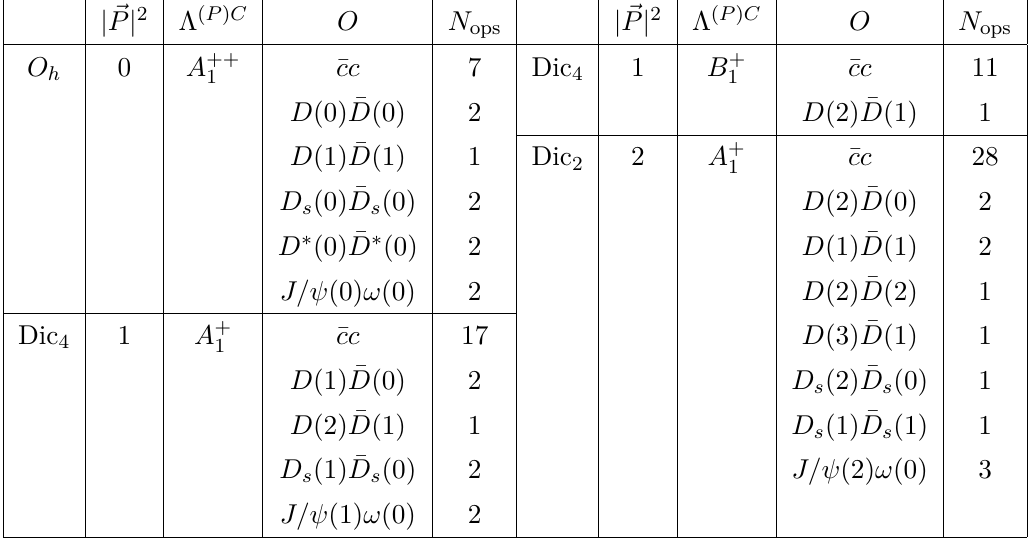
) M 2 ( ~p 2 ) for the two-meson interpolators with 1 2